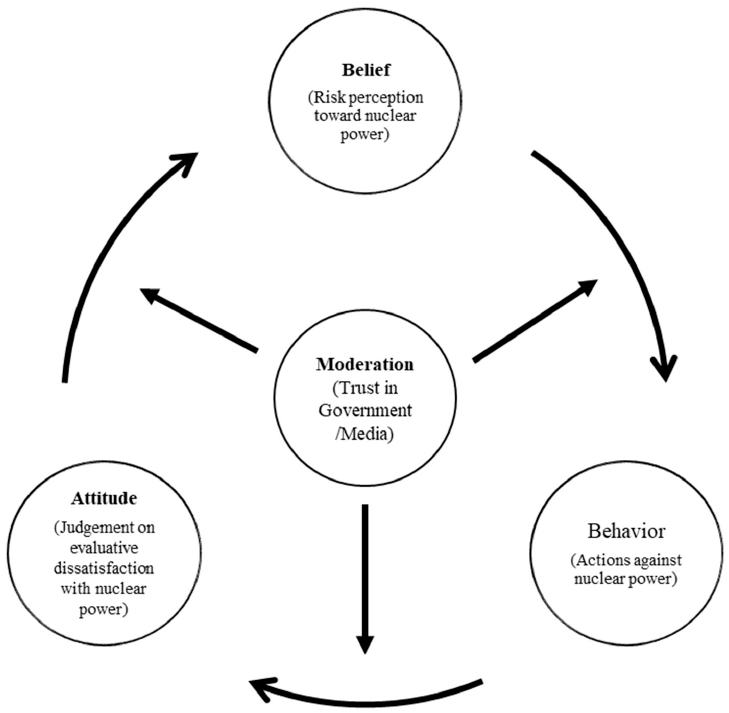
Figure 3. Conceptual framework of the relationship between belief, attitude, and behavior moderated by trust in government and media.